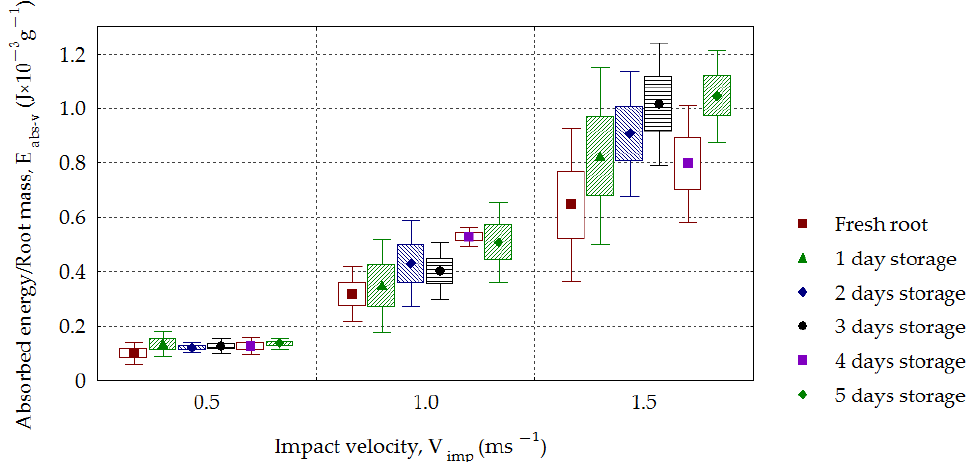
Figure 12. Dependence of absorbed energy related to mass ( E imp-v ) on the impact velocity ( V imp ) for the stored beets.